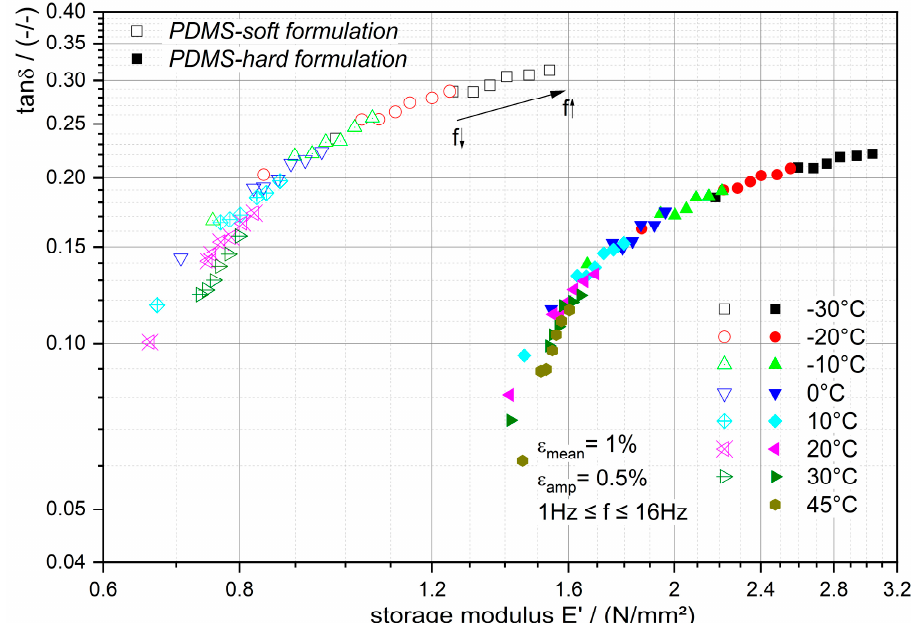
Figure 3. Loss factor tan δ over storage modulus E’ characteristic of the investigated materials at various temperatures .